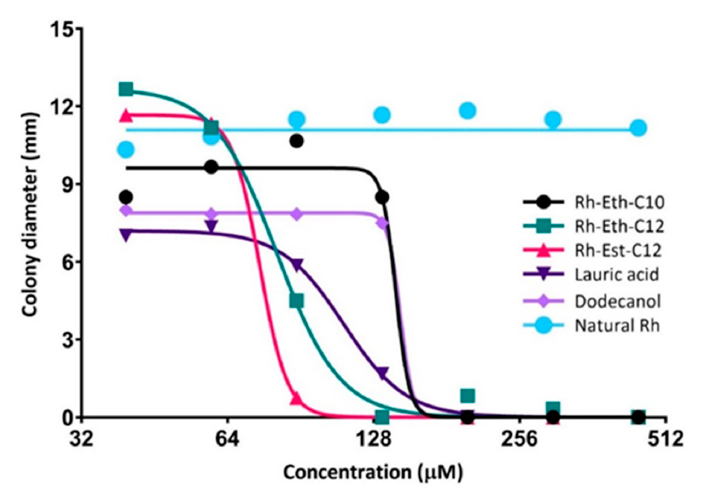
Figure 1. In vitro dose-response curves displaying the antifungal effect of the three most efficient RLs, as well as dodecanol and lauric acid, against Zymoseptoria tritici (strain T02596) compared to the natural RLs. Table 2. Biological activities, including in vitro direct antifungal activity, in planta defense activation and in planta protection efficacy of the eighteen synthetized RLs, as well as lauric acid, dodecanol and natural RLs, at 1.5 mM, on the wheat- Zymoseptoria tritici pathosystem.